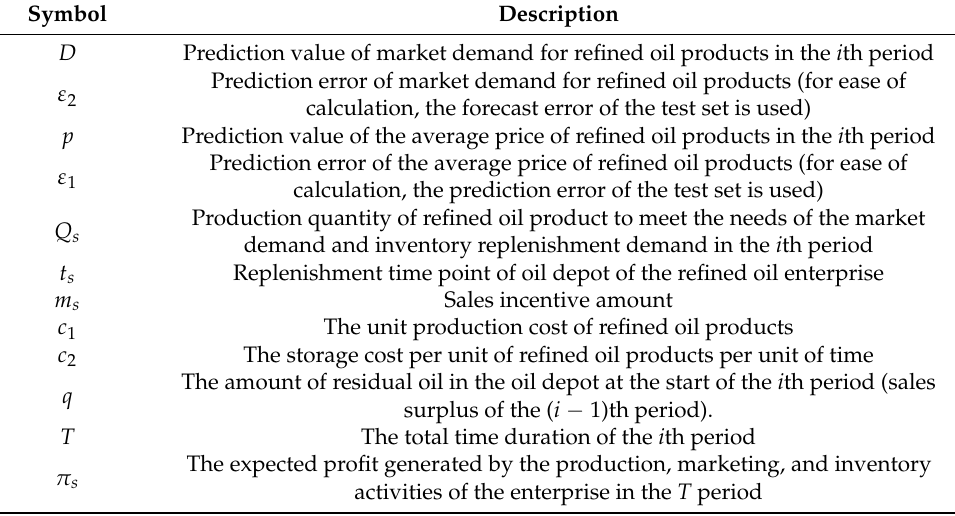
Table 1. A list of mathematical symbols. Symbol